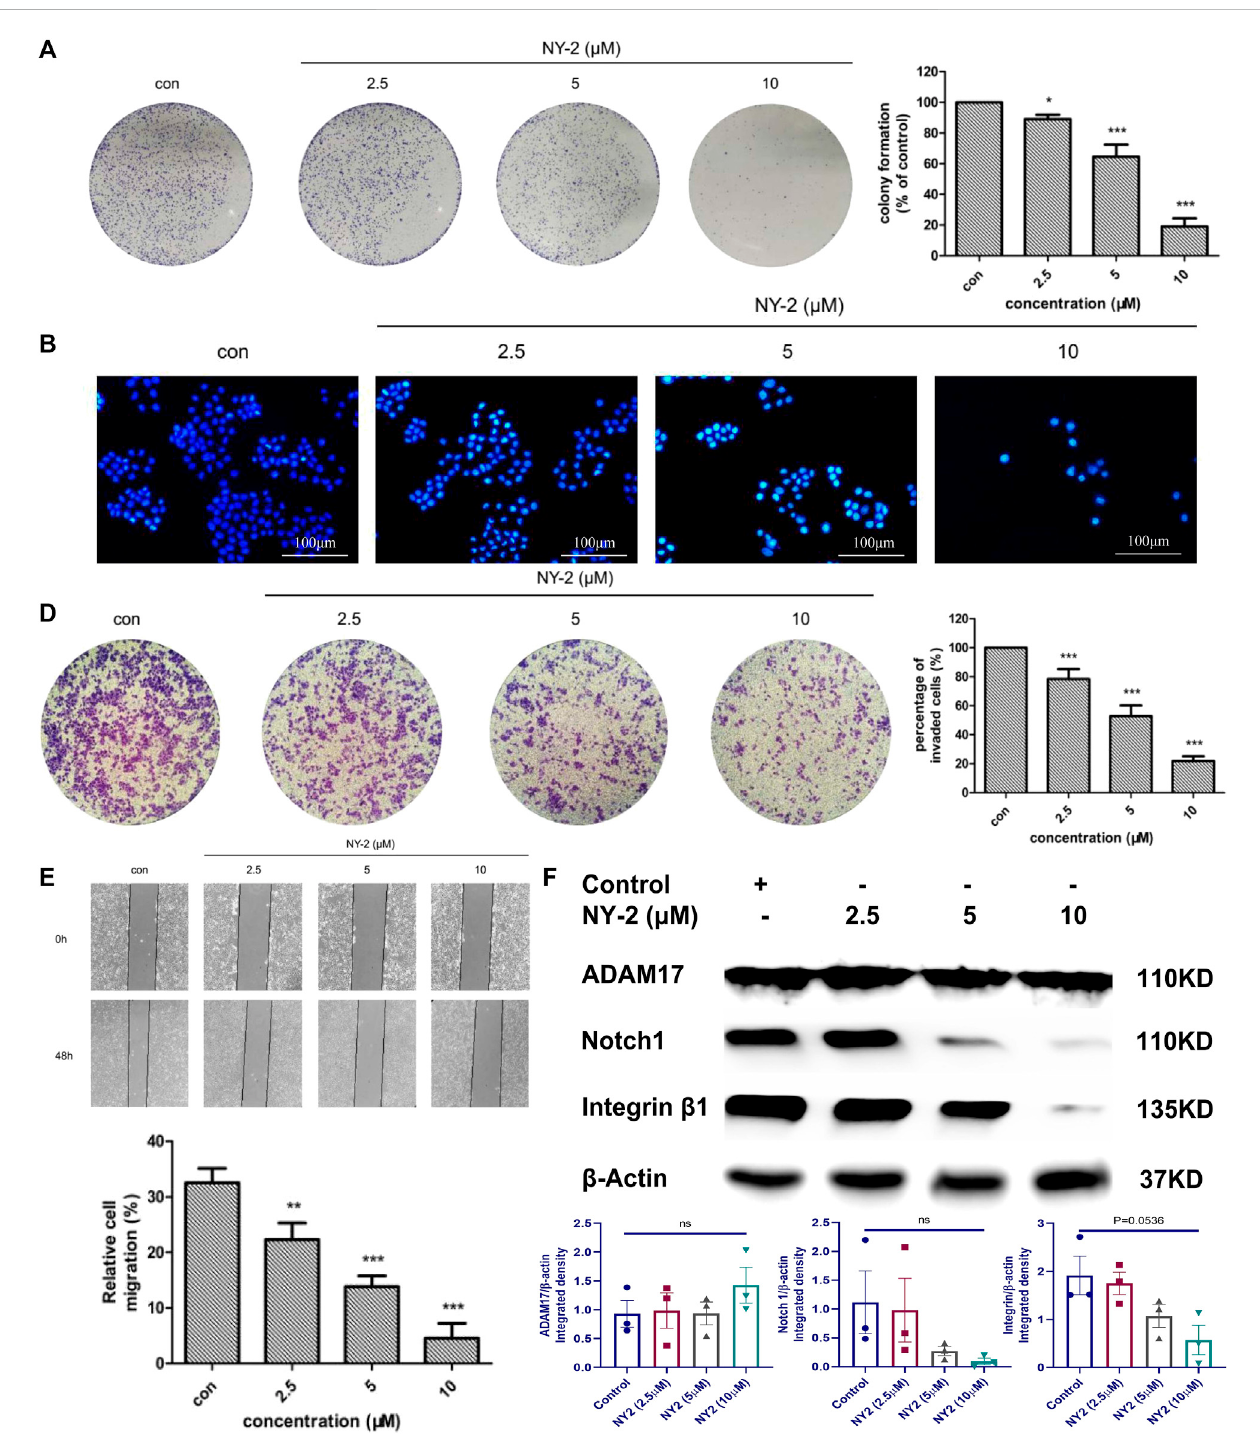
FIGURE 5 In vitro activity of NY-2 against NSCLC. Effect of NY-2 on colony formation of A549 cells (A) . NY-2 promotes apoptosis of A549 cells (Hoechst staining) (B) . NY-2 promotes apoptosis of A549 cells (annexin-V/PI double staining) (C) . NY-2 inhibits invasion of A549 cells (D) . NY-2 inhibits migration of A549 cells (E) . Western blot showing NY-2 reduces expression of Notch1 and integrin β 1 protein in dose-dependent manner (F) . * p < .05, ** p < .01, *** p < .001 ( n = 3, mean ±